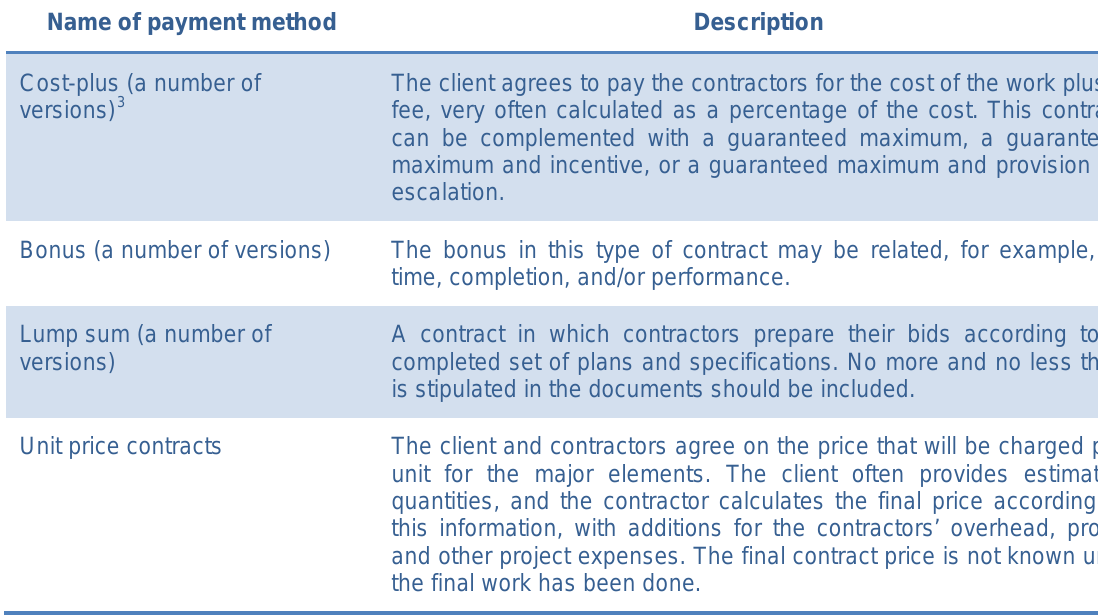
Table 7: Payment method structure in Ritz and Levy (2013, Ch. 2)